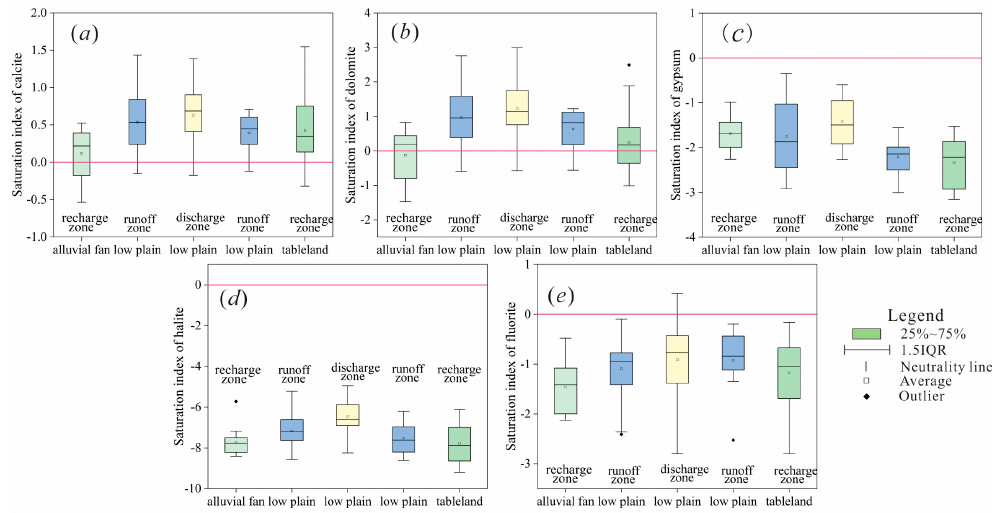
Figure 7. Saturation index in different partitions: ( a ) Calcite ( b ) Dolomite ( c ) Gypsum ( d ) Halite ( e ) Fluorite.